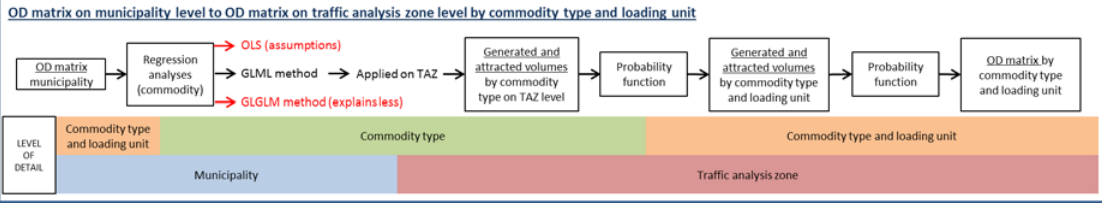
Figure 1. Research